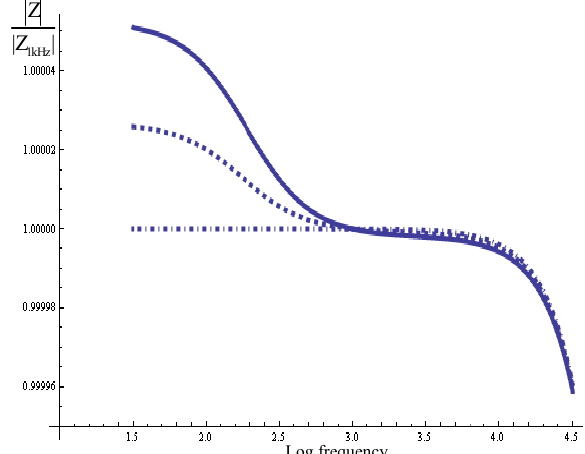
Fig.2.A: Permittivity spectra for suspensions of large cells ( R 1 ~ 0.5 mm), Δϕ 0 = -150 mV; σ 2 = 10 -6 S/m (solid); σ 2 = 10 -5 S/m (dashed